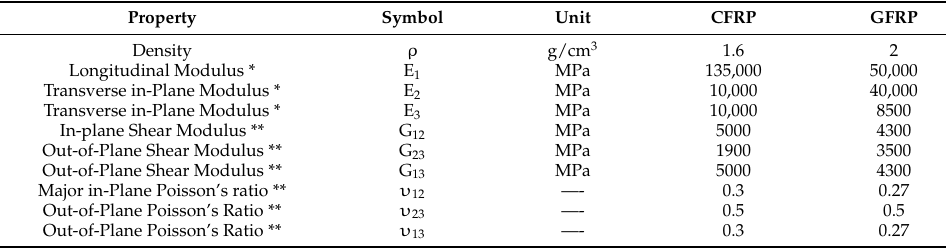
Table 6. Properties of CFRP and GFRP used for the numerical modelling.